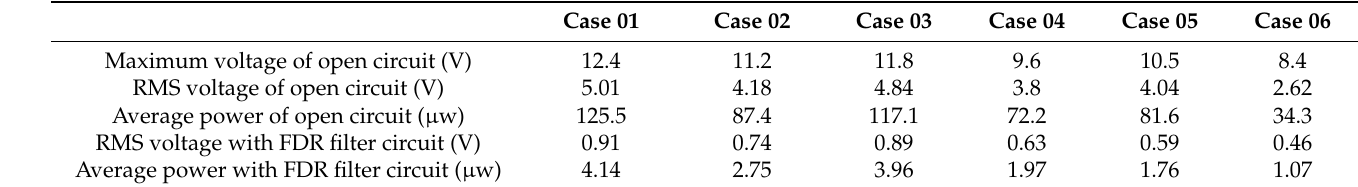
Table 3. Electrical output in each